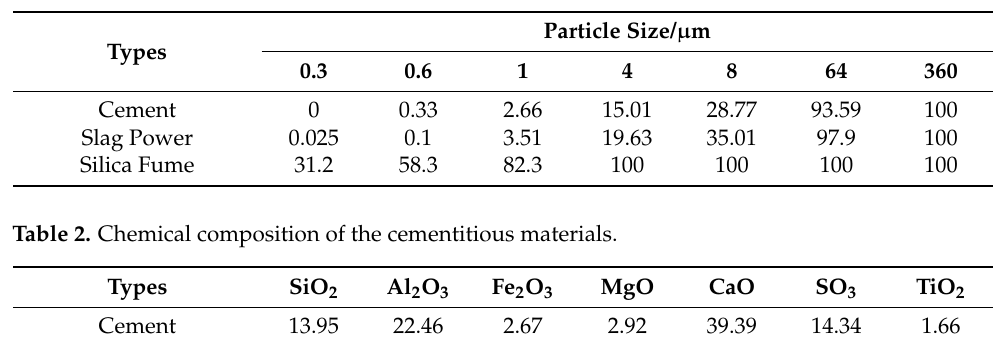
Table 1. Particle size distribution of the raw materials/%.